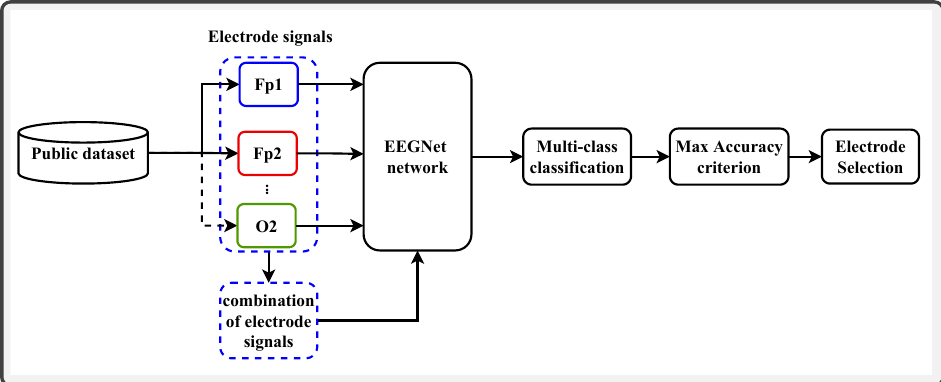
Figure 2. Overview of the proposed method. Each channel Data-stream ( FP 1, FP 2, . . . , O 2) and their combinations are processed using the EEGNet network to classify five fingers’ imagined movements. Next, the best test accuracies found from signals classification are used to locate the respective channels.